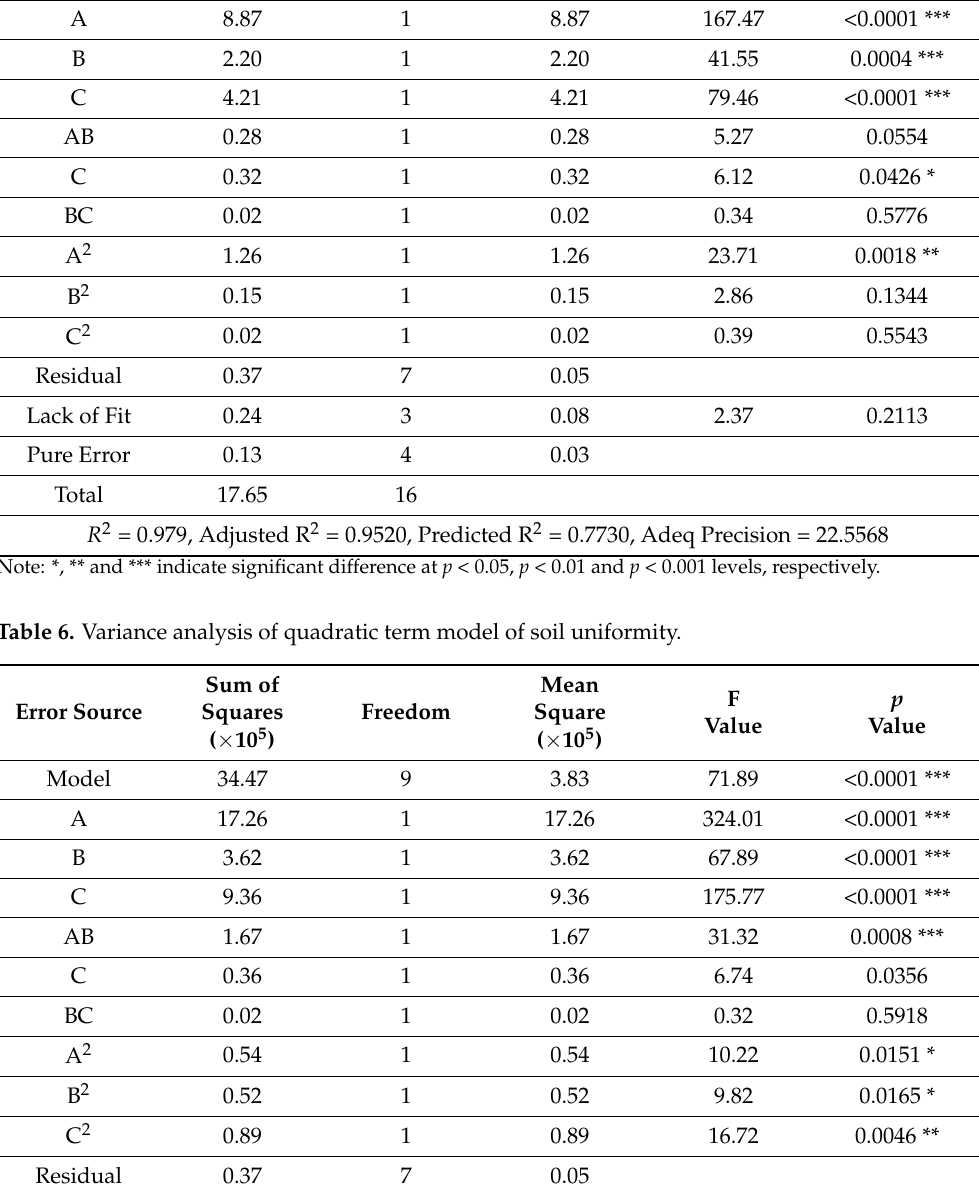
Table 5. Variance analysis of quadratic term model of soil separation distance. Sum of Error Source